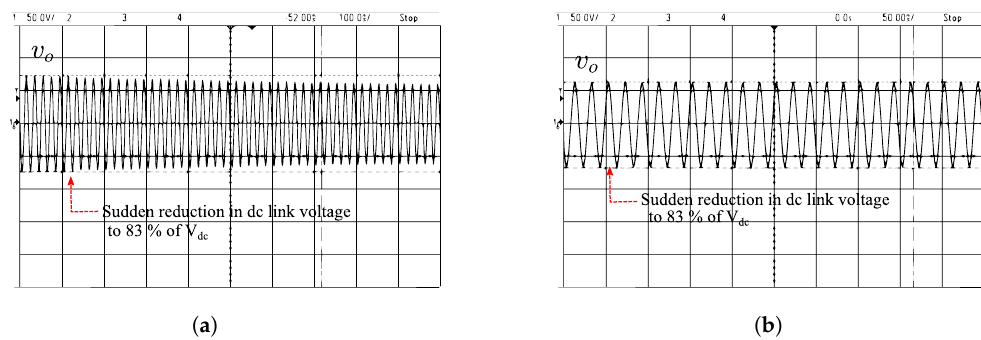
Figure 25. Performance comparison of the proposed system with conventional Sine PWM during a reduction in dc-link voltage of 20%. ( a ) Sine PWM: top trace: v o (50 V/div), bottom trace: i o (2 A/div). ( b ) Proposed logic: top trace: v o (50 V/div), bottom trace: i o (2